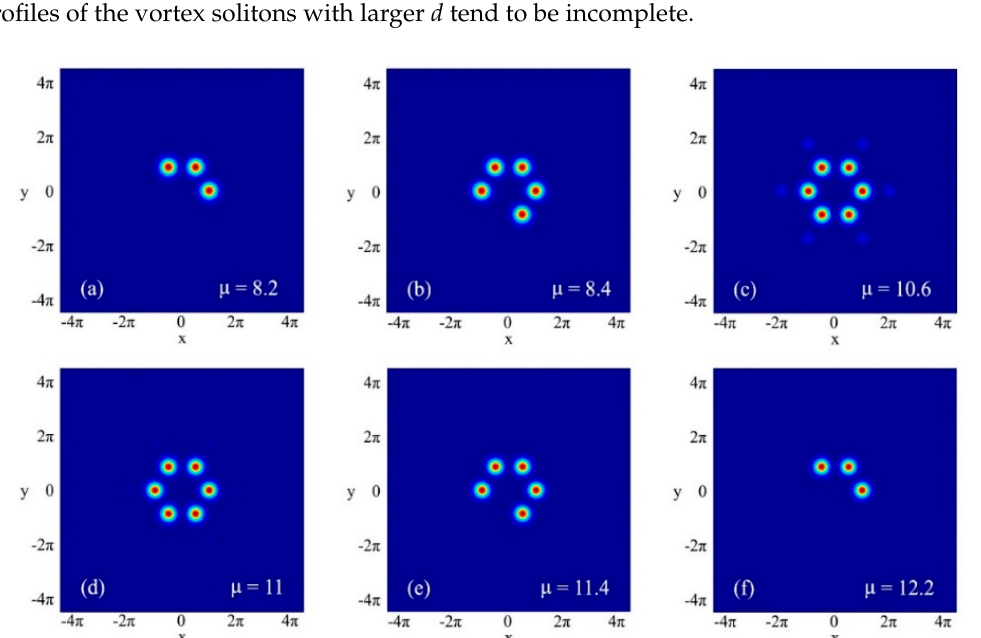
2 m = , which are shown in Figure